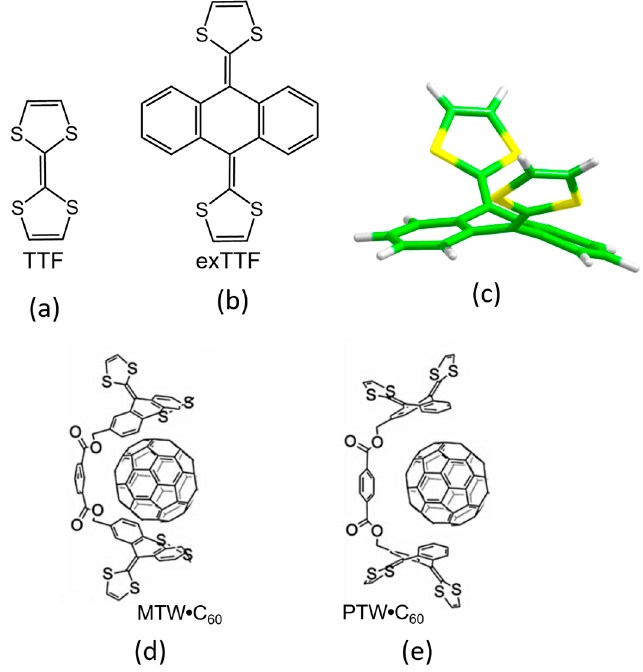
Figure 2. Chemical structure of TTF ( a ) and exTTF ( b ). The curved shape of exTTF is also represented ( c ). Sulfur, carbon and hydrogen atoms are colored in yellow, green and white, respectively.